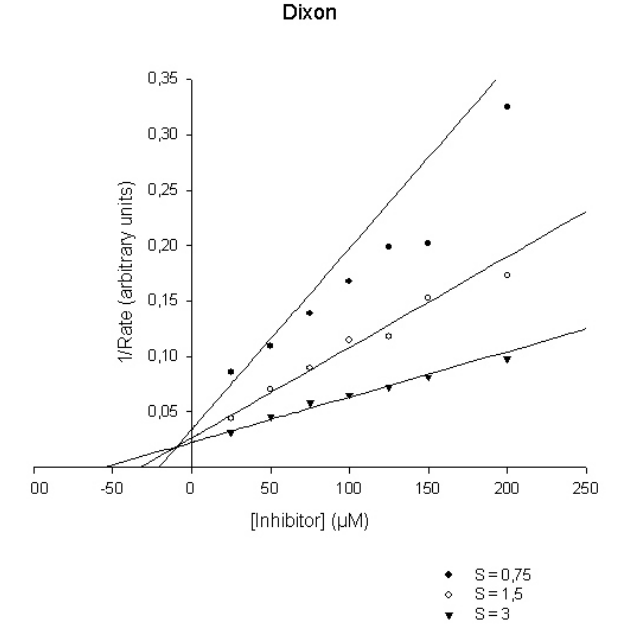
FIGURE 3. Dixon plot illustrating the competitive inhibition of CYP3A4 activity by fluoxetine (Ki = 9.5 (cid:181)M) in human liver microsomes. Unpublished results from P. Kremers, ATC LiŁge, Belgium.